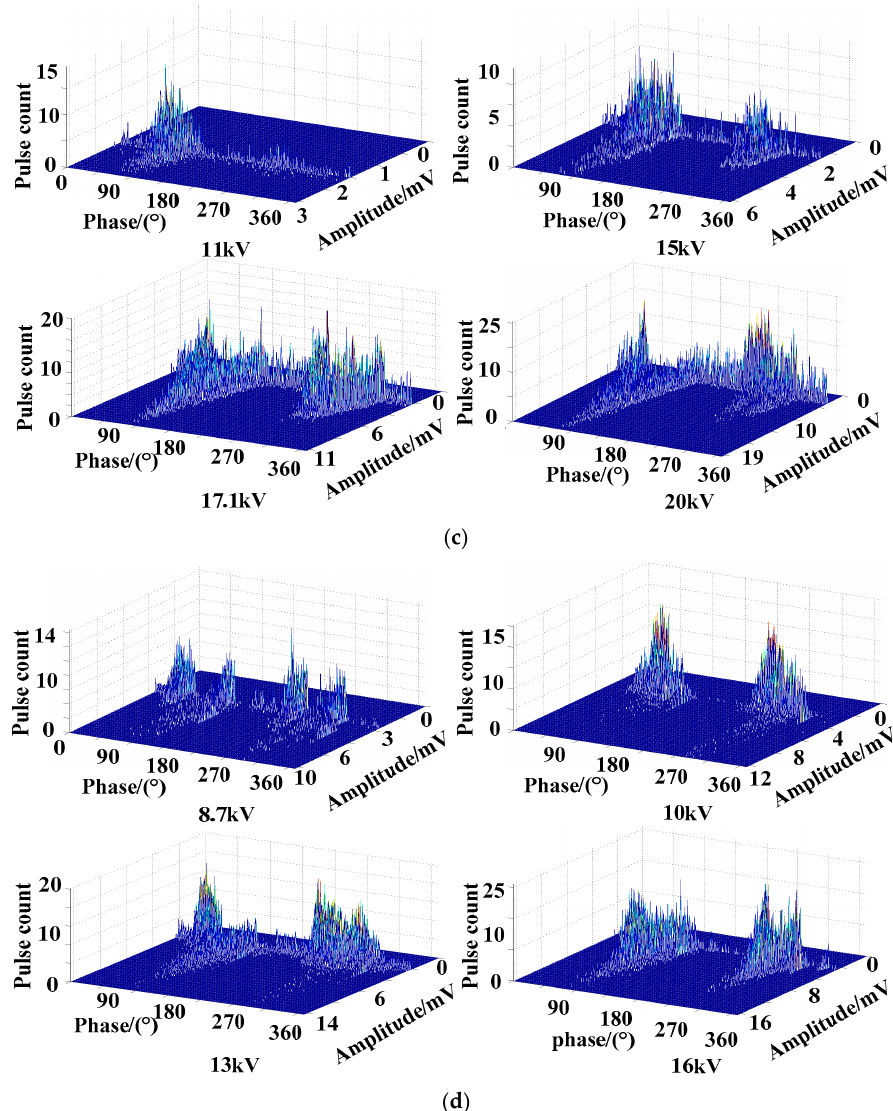
Figure 3. PD φ -u-n PD-pattern of the four artificial defects. ( a ) The 3D PD-pattern of the N defect; ( b ) the 3D PD-pattern of the G defect; ( c ) the 3D PD-pattern of the P defect; and ( d ) the 3D PD-pattern of the M defect.